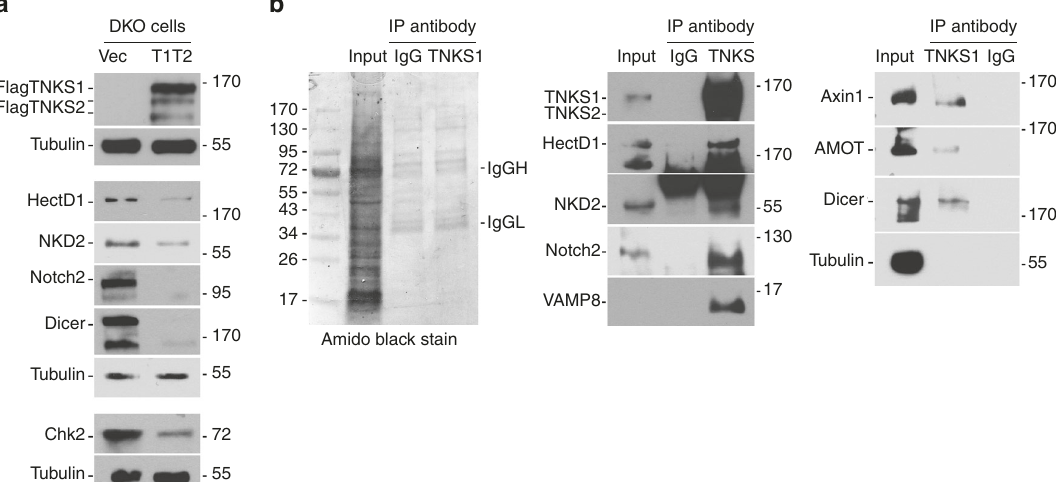
Fig. 4 Rescue and immunoprecipitation analysis of candidates for the proteomic screen. a Reintroduction of tankyrases into DKO cells induces loss of candidate proteins. Immunoblot analysis of HEK293T DKO cells stably expressing a vector control or Flag-TNKS1 and Flag-TNKS2 (T1T2) with the indicated antibodies. b Coimmunoprecipitation of candidate proteins with tankyrase. Immunoblot analysis of HEK293T cells immunoprecipitated with control or TNKS IgG, stained with amido black (left panel) and probed with the indicated antibodies (middle and right panels)